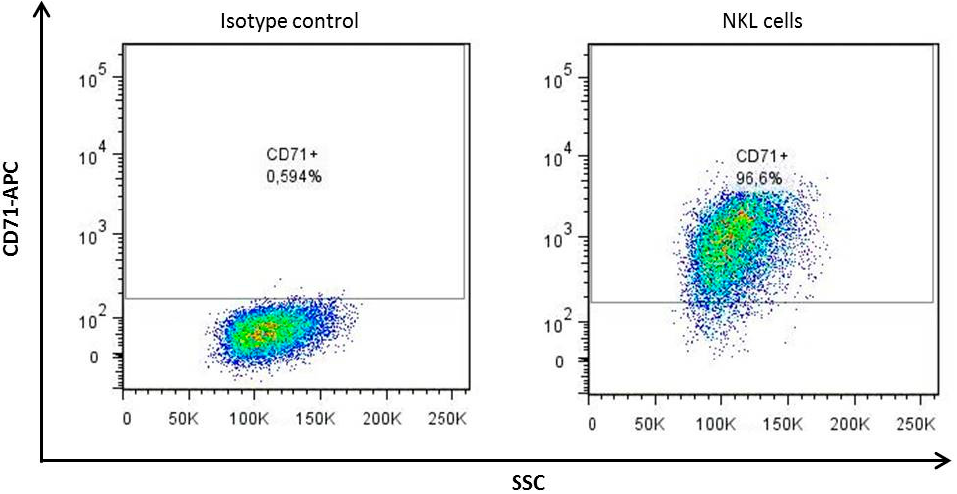
Figure A1. The transferrin receptor TRF1 (CD71) is expressed on the cell surface of NKL cells. Presence of the transferrin receptor was checked in order to use this receptor as positive control. Measurement was performed in duplicates; one representative is shown.